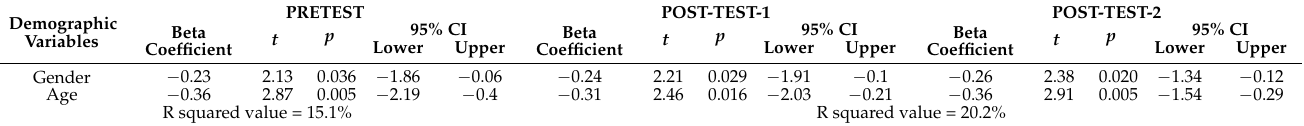
Table 7. Regression Analysis of DBP with Demographic Variables among Study